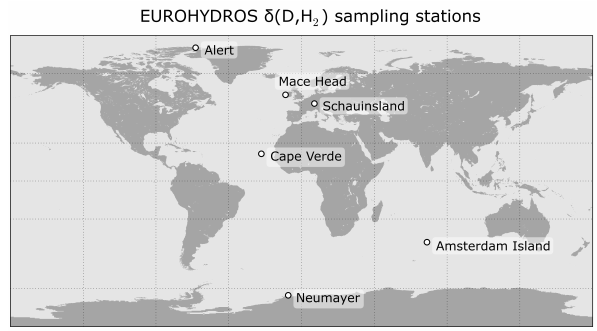
Fig. 1. The six EUROHYDROS stations that were used for δ D